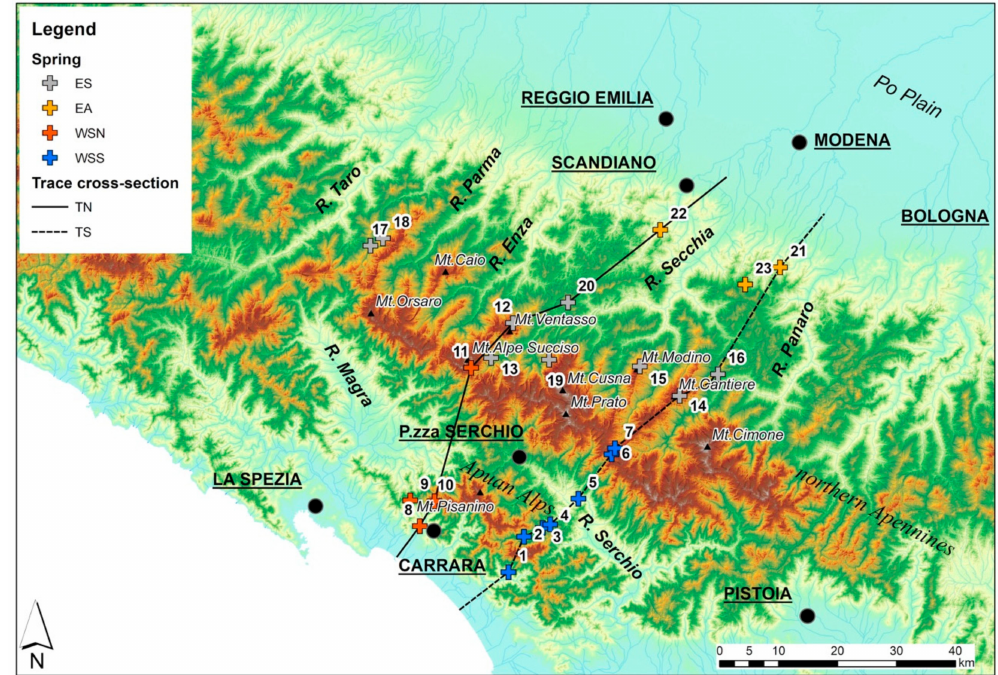
Figure 2. Location of the study area, indicating the altitudinal transects and the studied springs (see Table 1 for definition of the springs number). ES: eastern side spring; EA: eastern side Adriatic spring; WSN: western side spring (Northern transect); WSS: western side spring (Southern